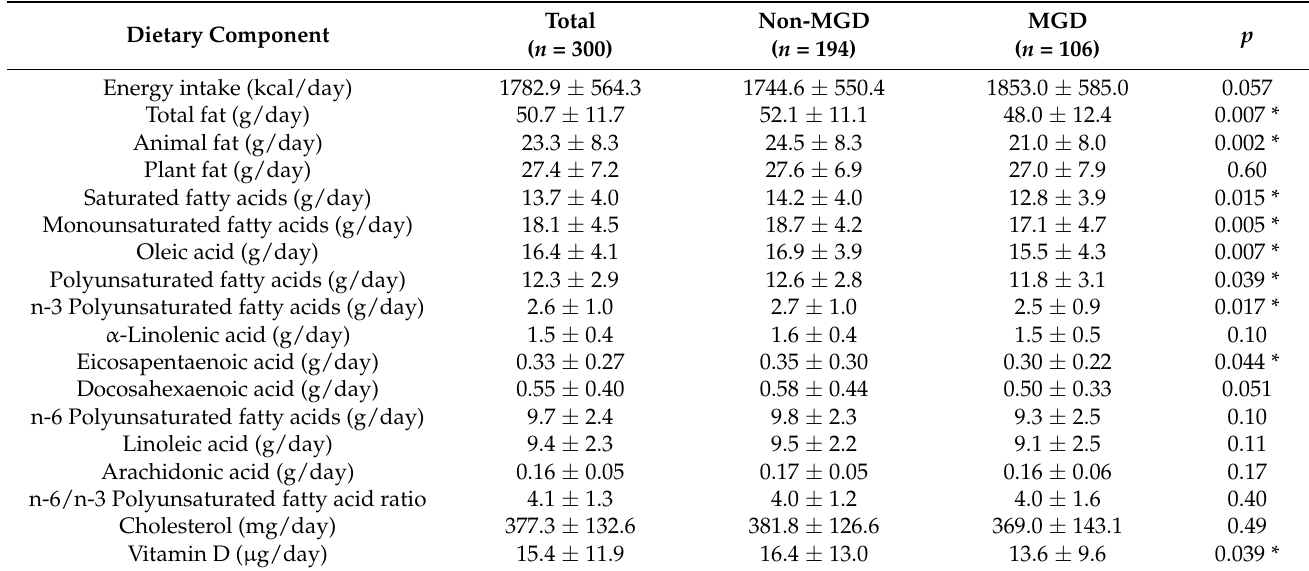
Table 2. Daily intake of dietary components in adult subjects with or without meibomian gland dysfunction (MGD) in the Hirado–Takushima